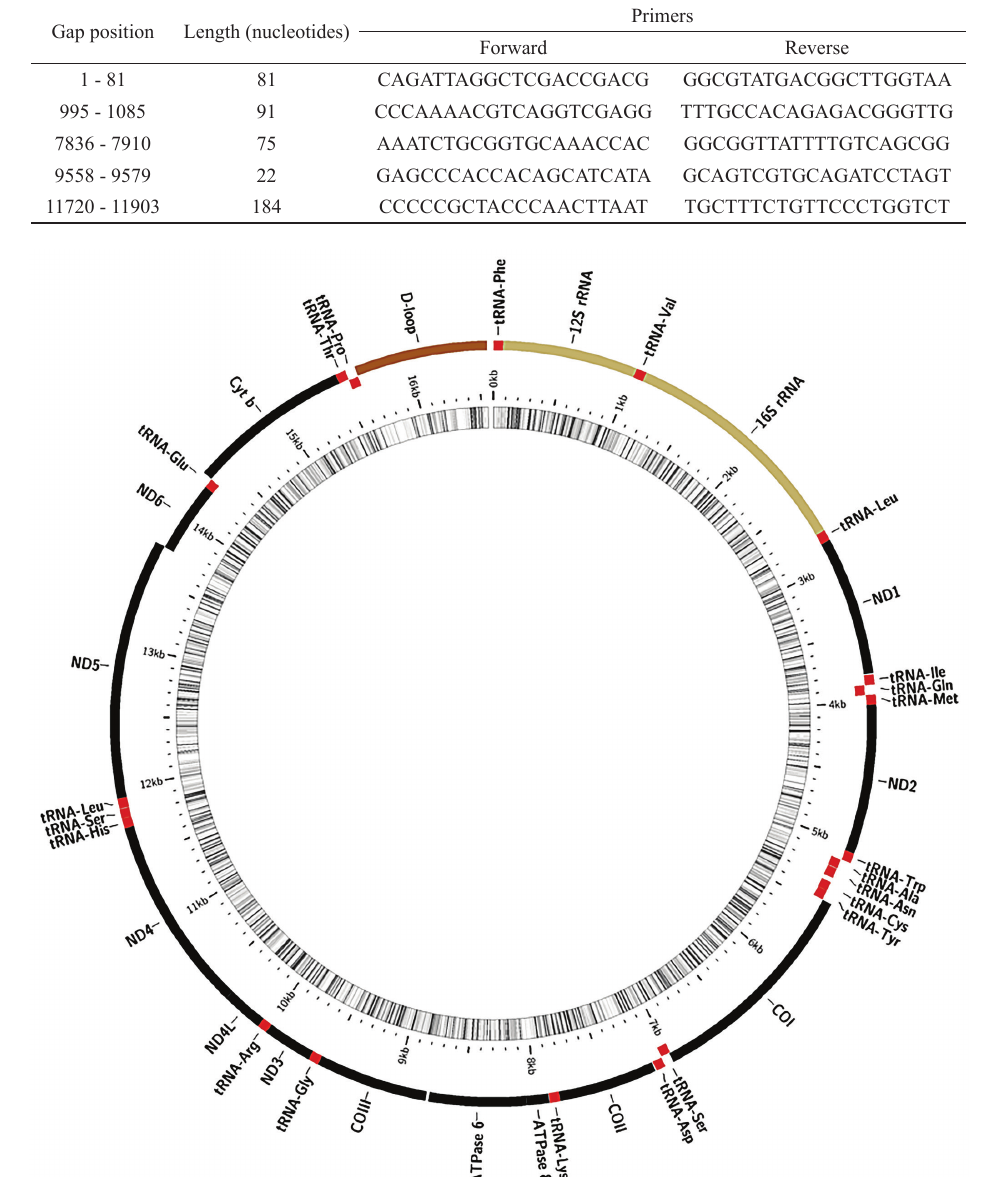
Fig. 1. Circular representation of the mitochondrial genome of Corydoras nattereri . Genes encoded in the heavy strand are shown in the outer circle and genes encoded in the light strand are offset inwards. The inner circle represents the CG-content. Figure was generated by the online server MitoFish, http://mitofish.aori.u-tokyo.ac.jp (Iwasaki et al .,